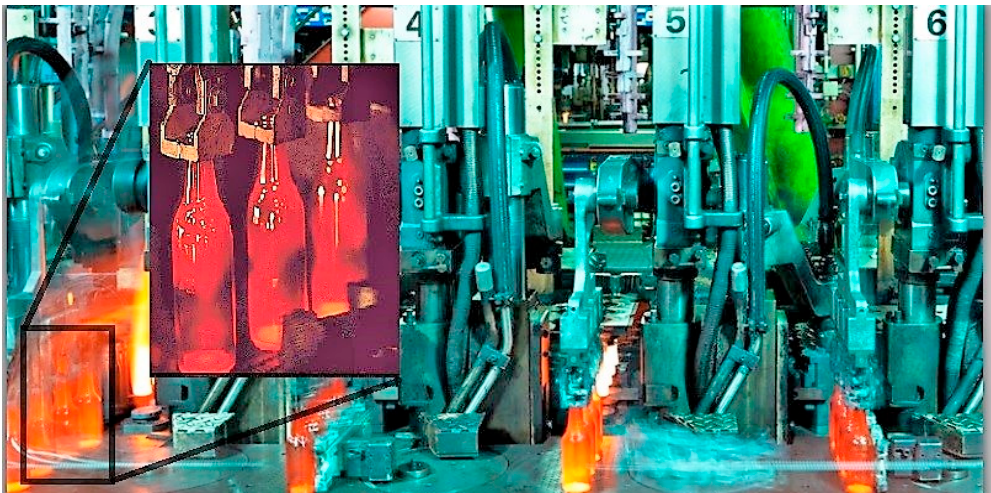
Figure 2. An overview of a typical ISM showing the operation of the plunger mechanism for take-out (Enlarged) [13] .